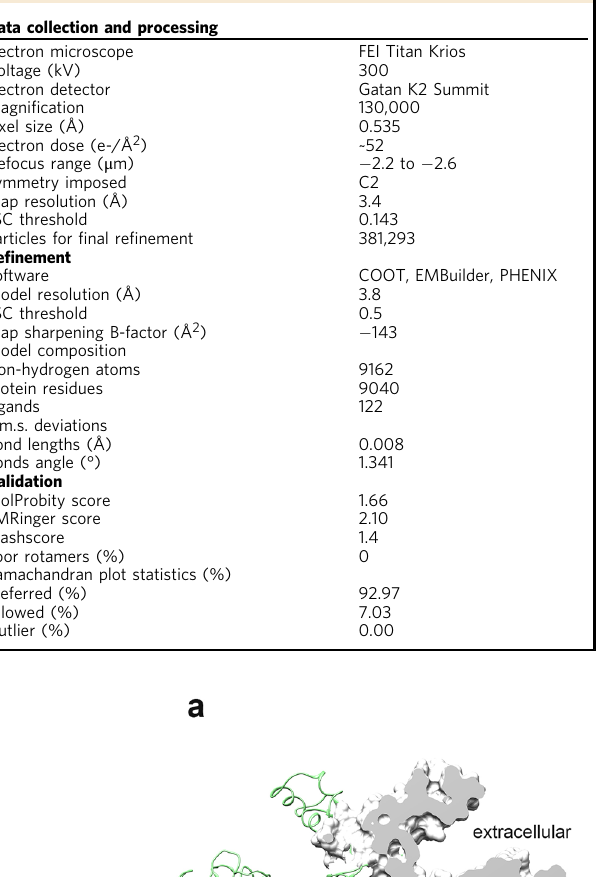
Table 1 Data collection, re fi nement and validation